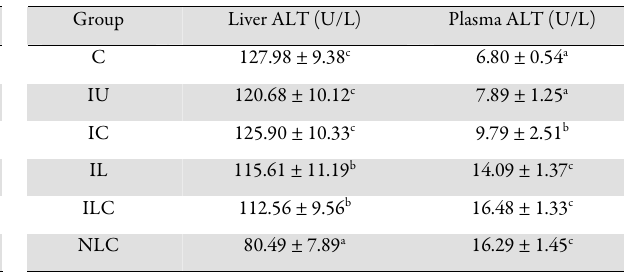
Infected treated with chloroquine, IL – Infected treated with lumefantrine (pure), ILC- Infected treated with lumefantrine - copper complex